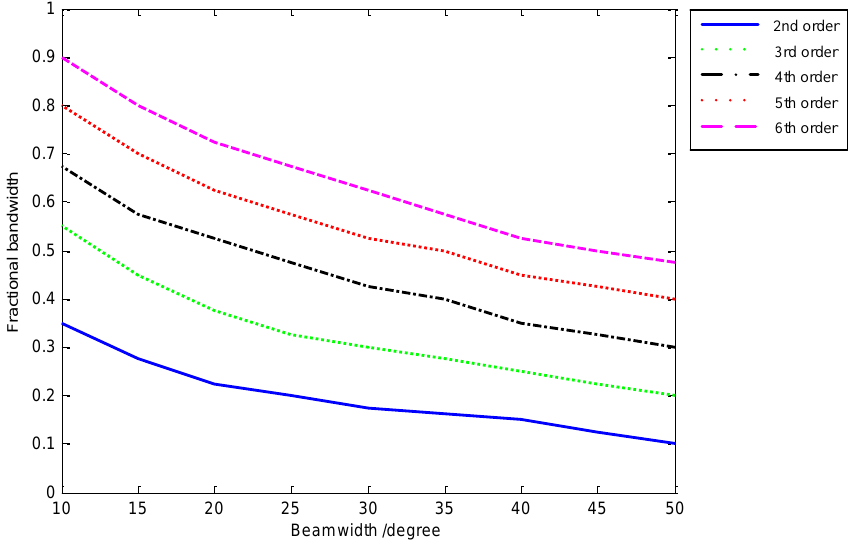
Figure 4. An example of the required order of different beamwidth and fractional bandwidth in a P-band synthetic aperture radar (SAR)